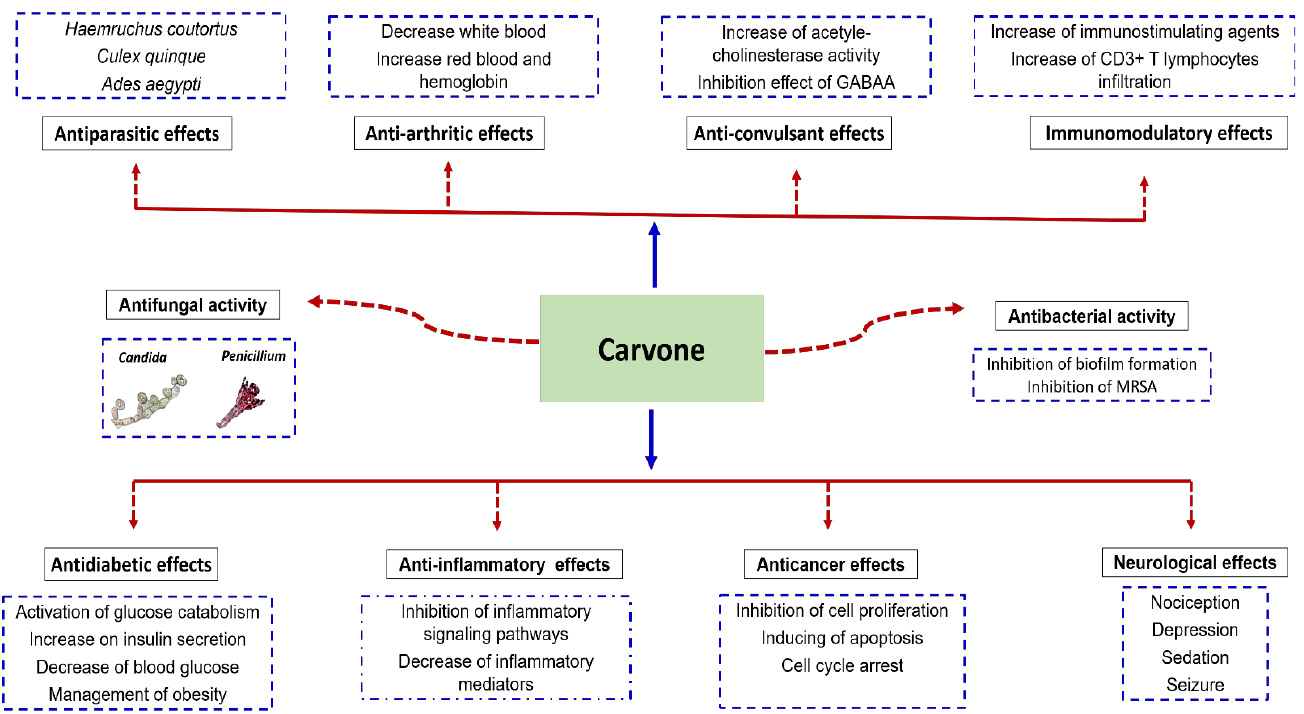
Figure 2. Pharmacological properties of carvones. Carvone exhibits multiple biological activities including antidiabetic, anti-inflammatory, anticancer, neurological, antimicrobial, antiparasitic, antiarthritic, anticonvulsant, and immunomodulatory effects.